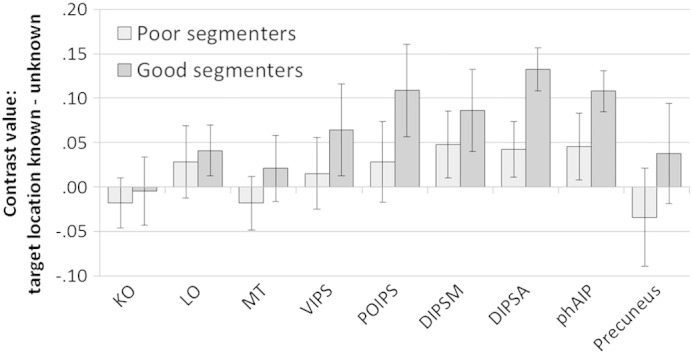
Change in activation when target location was known versus unknown, in each of the regions of interest (ROIs), for good and bad segmenters (based on a median split of reaction-time benefit). Error bars show standard errors. KO, kinetic occipital; LO, lateral occipital; MT, MT/MT +; VIPS, ventral intraparietal sulcus; POIPS, parieto-occipital intraparietal sulcus; DIPSM, medial dorsal intraparietal sulcus; DIPSA, anterior dorsal intraparietal sulcus; phAIP, putative human anterior intraparietal area.